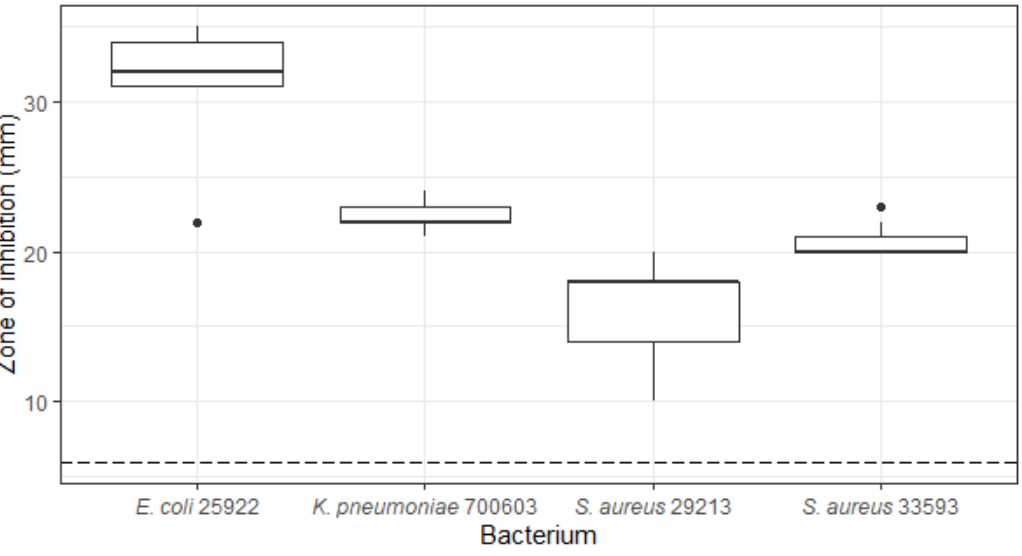
Figure 2. Antibacterial activity of Penicillium bissettii ICMP 21333 against Escherichia coli , Klebsiella pneumoniae , and Staphylococcus aureus . The antibacterial activity of P. bissettii ICMP 21333 was measured by the production of zones of inhibition (mm) when fungal plugs were incubated on lawns of E. coli ATCC 25922, K. pneumoniae ATCC 700603, S. aureus ATCC 29213 (antibiotic-sensitive), and S. aureus ATCC 33593 (antibiotic-resistant). Boxes are upper and lower quartiles with median shown. The whiskers extend up to 1.5× the inter-quartile range, and any dots beyond those bounds are outliers. The dotted line represents the diameter of the fungal plugs. Experiments were performed on three separate occasions with three technical replicates per experiment.